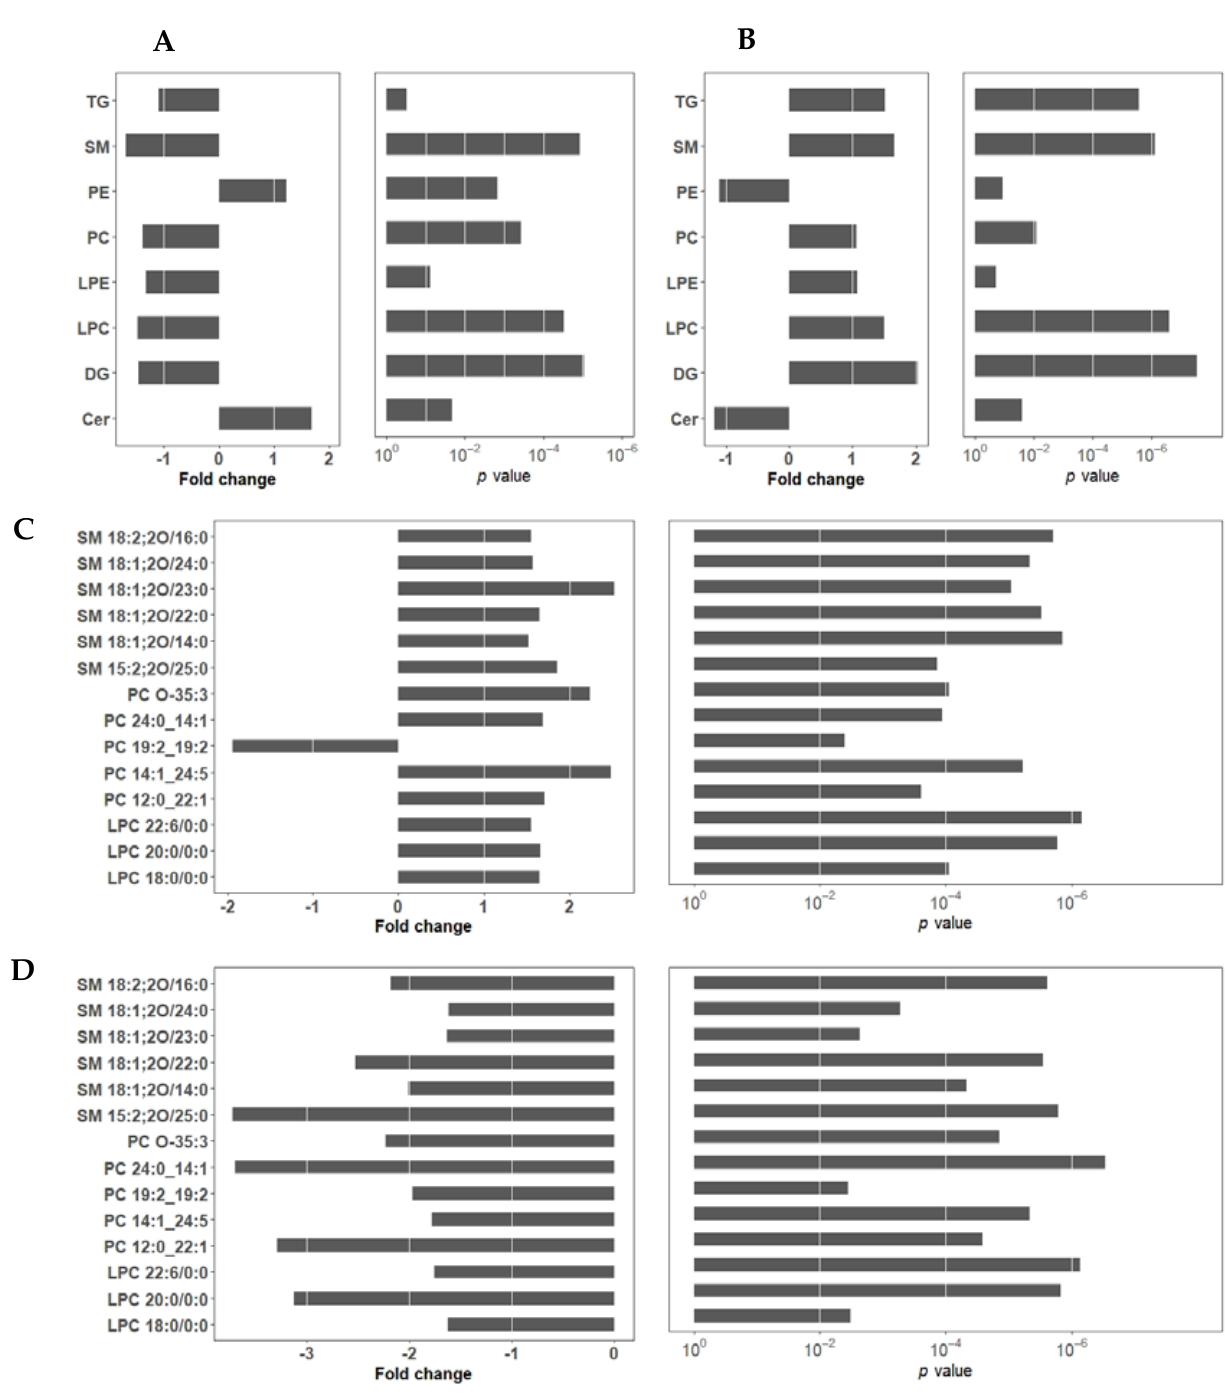
Figure 6. Fold changes in the serum lipid classes before and after CDAA diet feeding ( A ); fold changes in the serum lipid classes before and after PPC treatment ( B ); fold changes in the serum lipid species before and after CDAA diet feeding ( C ); and fold changes in the serum lipid species before and after PPC treatment ( D ).